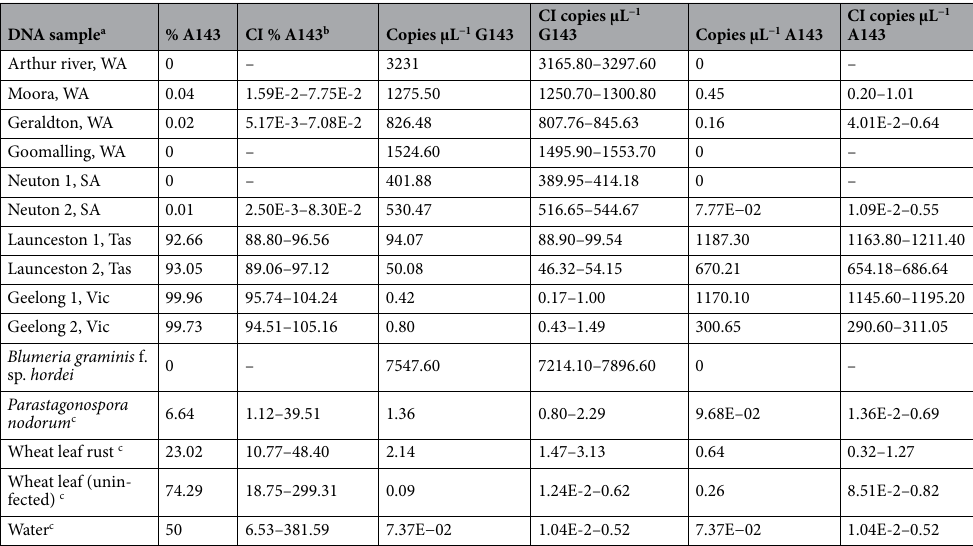
Table 3. Specificity of detection of the G143A dPCR assay on total DNA from Blumeria graminis f. sp. tritici infected wheat leaf field samples and controls. a WA Western Australia, SA South Australia, Tas Tasmania,